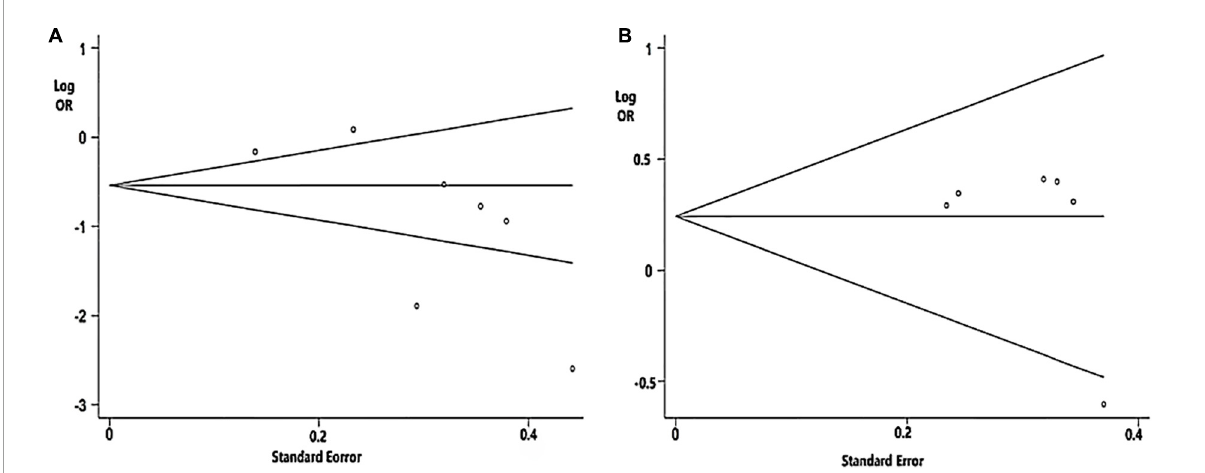
FIGURE3 Funnel plot analysis used to detect publication bias: (A) CSF A β 42 level ( P = 0.072 in Begg’s test); (B) Cerebrospinal fluid (CSF) t-tau level ( P = 0.452 in Begg’s